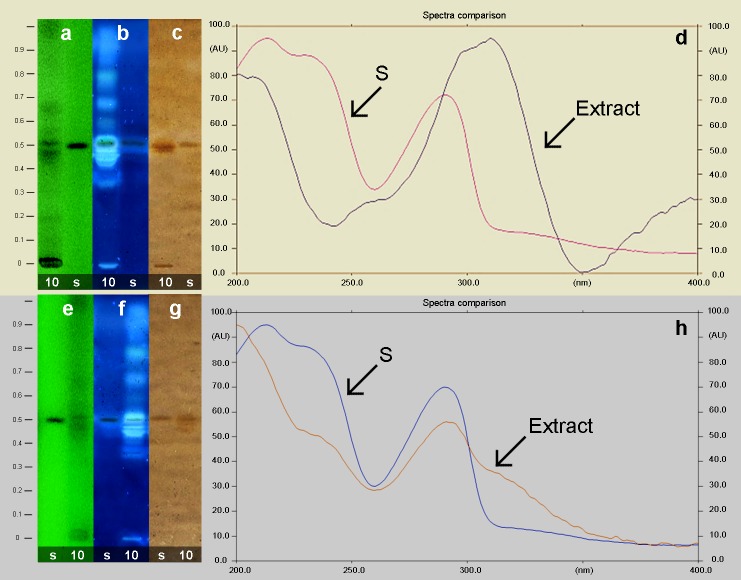
Identification of PTOX by HPTLC-Scan.Lane 10 indicates the HsTD10 HR-line extract, and the standard (POTX,
Sigma) is referred to as letter “s”. The profiling of the different
solvent extractions MeOH-CH2Cl2 (a,
b, and c) and CHCl3
(e, f, and g) are presented.
Developed-plate visualizations at 254 nm (a, and
e), cerium sulfate revealed-plate at 366 nm
(b, and f), and white light
(c, and g) are shown. Absorbance spectra
from the spots of PTOX in both extracts (d, and
h) are shown.